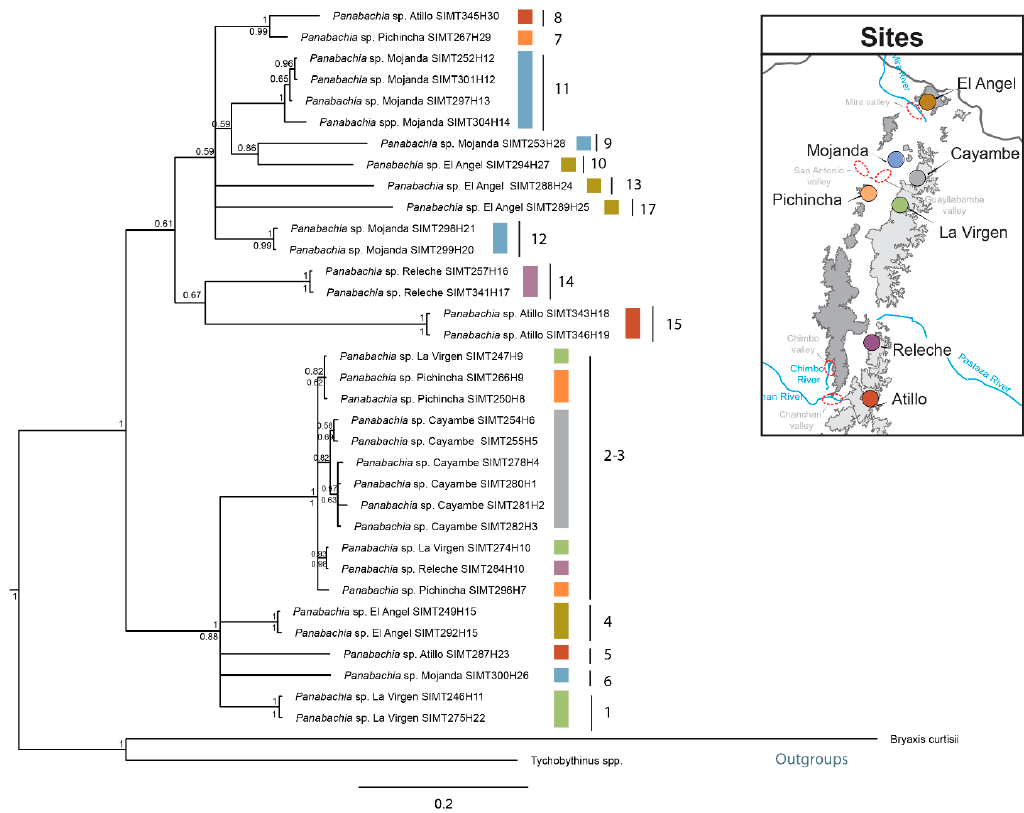
Figure 5. Posterior probability tree for the mitochondrial gene COI of Panabachia . Branch lengths are in proportion to the number of substitutions per site, in reference to the scale bar. Posterior probabilities are shown above the branches and bootstrap support values for the Maximum Likelihood tree are shown below branches.